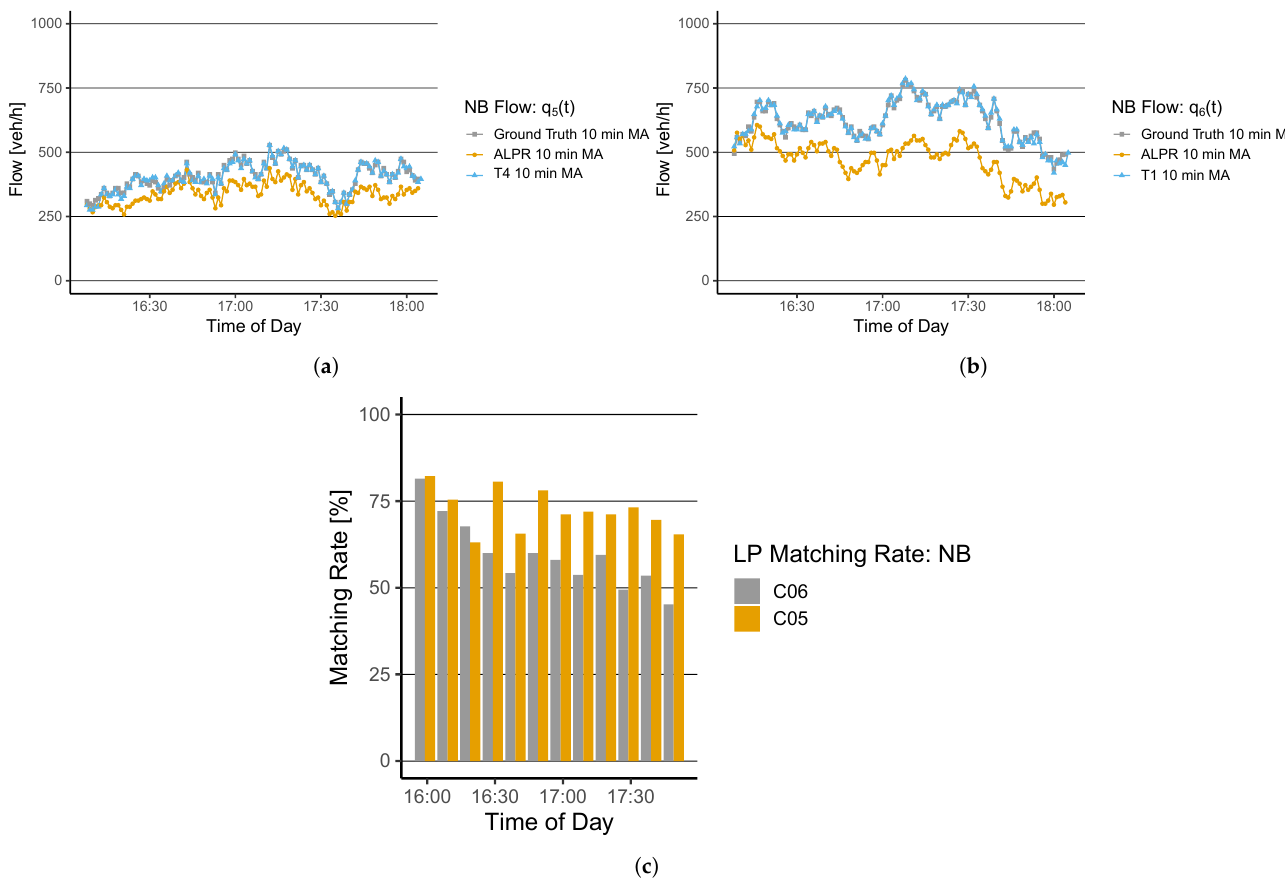
Figure 7. Flow evaluation ( a ) q 5 ( t ) and ( b ) q 6 ( t ) at NB from the ground-truth measurement, the ALPR, and the thermal camera T4 and T1; ( c ) shows the matching rate of the ALPR algorithm for both derived flows.